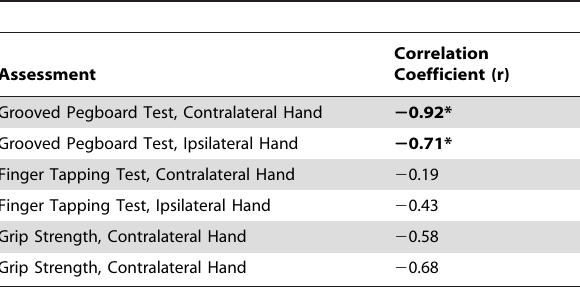
Table 2. Association of Rolandic gamma response with motor function.